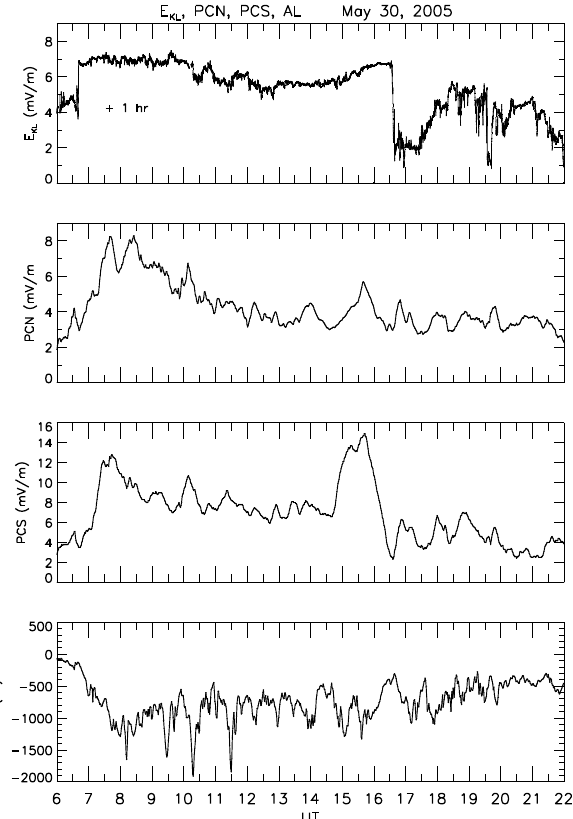
Fig. 3. Panels from top to bottom shows E KL based on observations from spacecraft Wind, the polar cap indices in the Northern (PCN) and Southern (PCS) Hemispheres, and the AL-index (bottom panel) for the interval 06:00–22:00UT (30 May